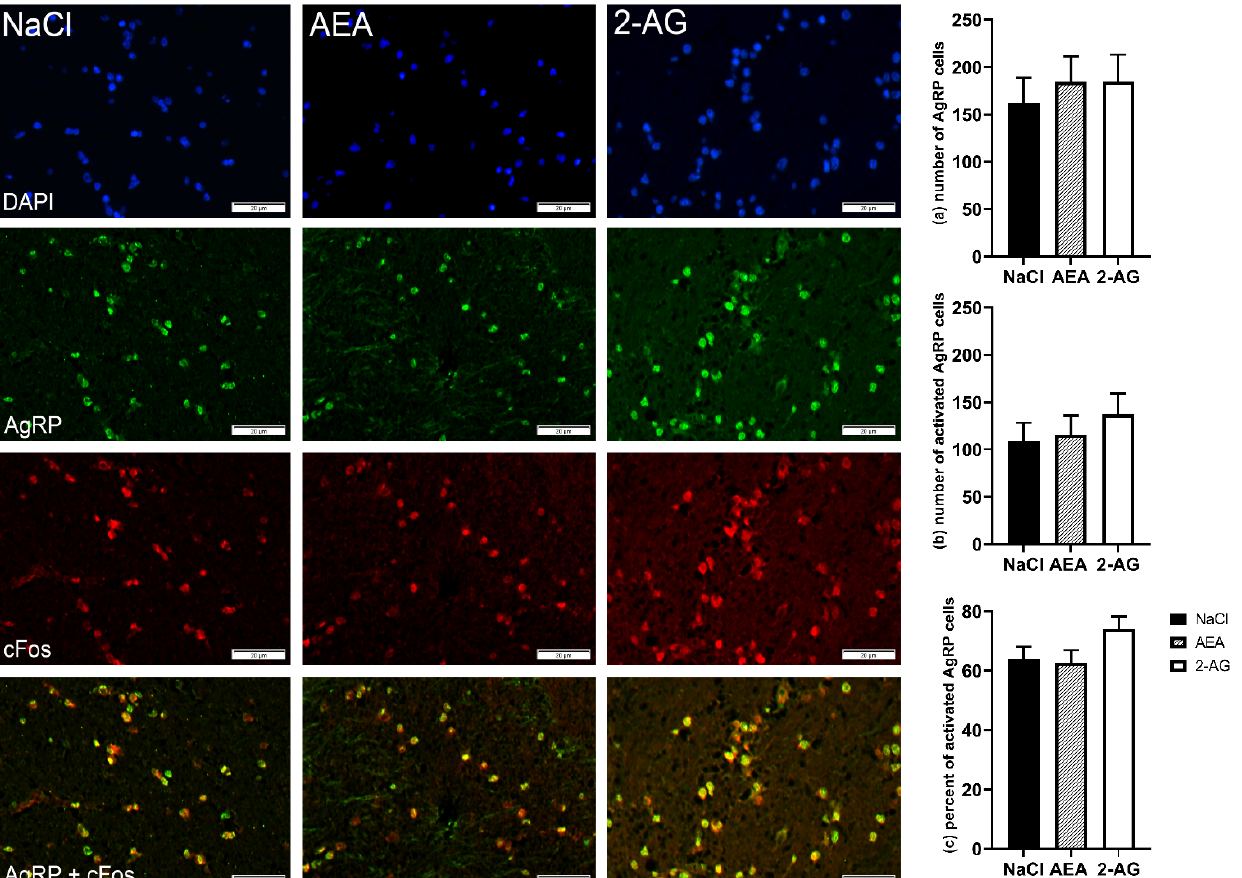
Figure 4. Immunofluorescence staining and representative images of the arcuate nucleus (ARC) of cows after intraperitoneal administration with NaCl ( n = 7), AEA ( n = 7) or 2-AG ( n = 6) for 9 days. DAPI-stained nuclei (blue), AgRP neurons (green), cFos (red) and co-localization (merged image). Scale bar within images indicates 20 µ m. Number of AgRP neurons ( a ), number of cFos-positive AgRPcells ( b ) and the percentage of activated AgRP cells per total AgRP cells ( c ). Data are shown as LSM ± SE with ( a ) F (2,17) = 0.25, p = 0.80, ( b ) F (2,17) = 0.51, p = 0.61, ( c ) F (2,15) = 2.11, p = 0.16